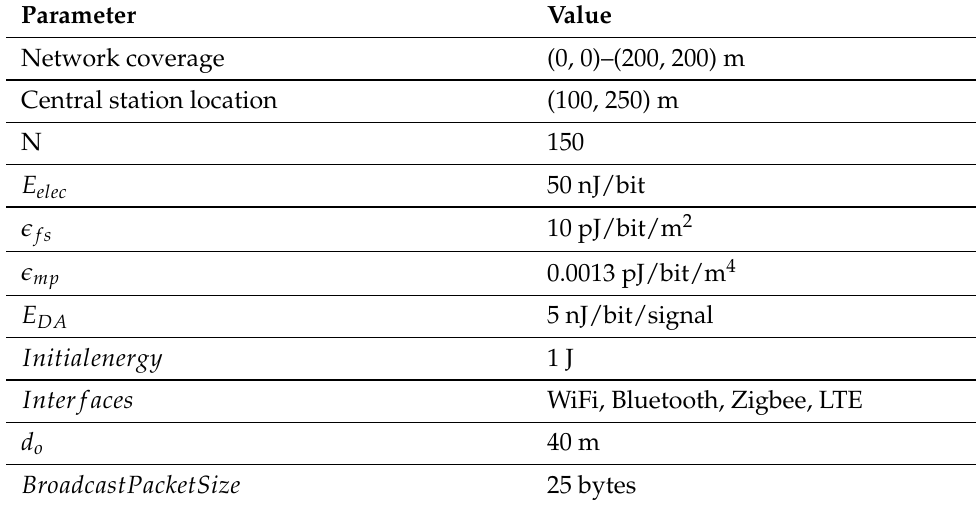
Table 2. Simulation parameters of